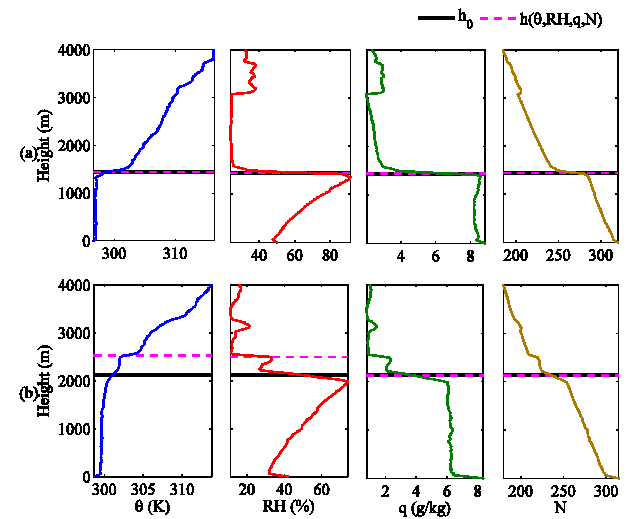
Figure 2. The profiles of relative humidity (RH), potential tem- perature ( θ) , specific humidity ( q) , refractivity ( N) and the mixing layer height ( h ) derived from these profiles. The y axis is the height above the ground level. The h determined by individual standard (magenta dotted line) and h 0 which integrates the information of θ , RH, q and N (black solid line) are also shown. (a) Station #14898 at 00:00UTC on 13 August 2006, (b) station #14898 at 00:00UTC on 23 August 2006. (Station #14898: 44.5 ◦ N, 88.1 ◦ W, LST: 18:06).